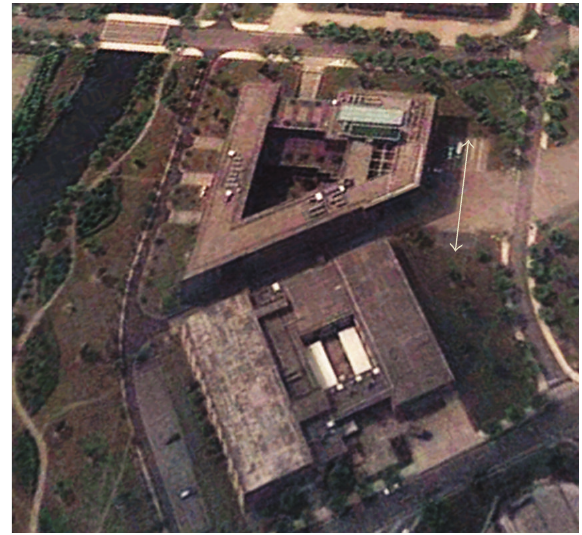
Figure 9: Field test Scenario